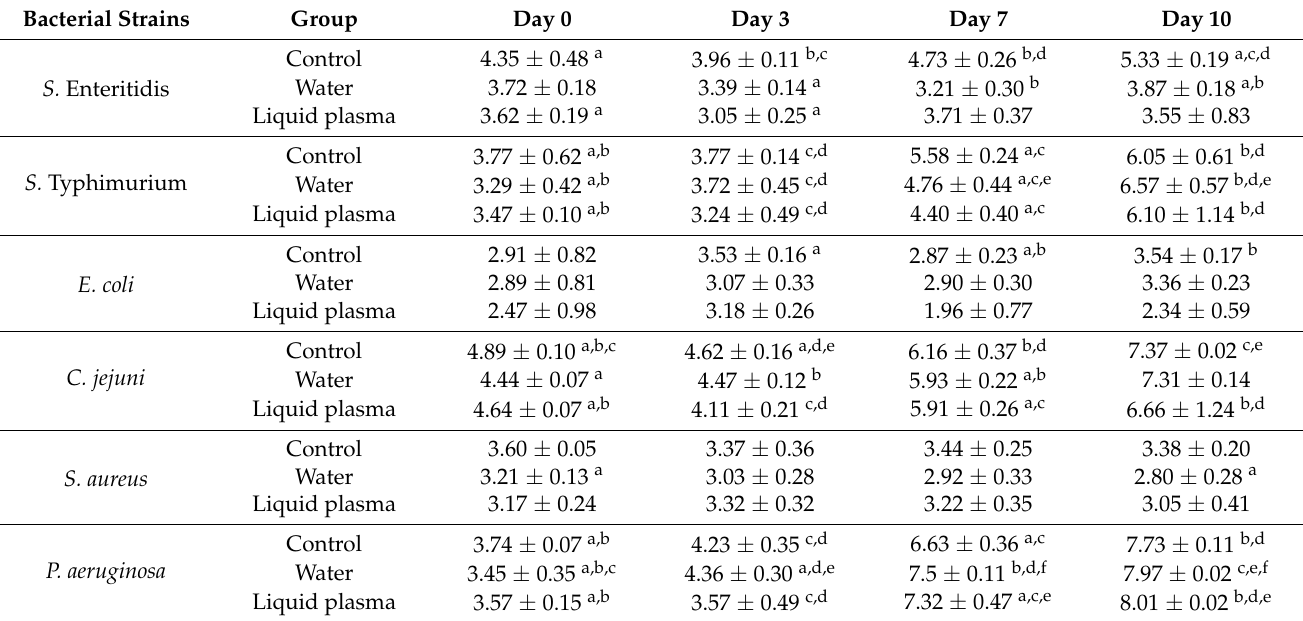
Table 4. Means of the microbial loads (log CFU/g ± SD) of chicken samples at days 0, 3, 7, and 10 after being stored under refrigerated conditions.